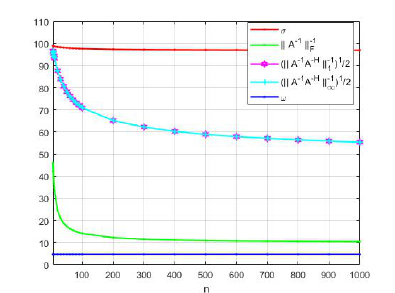
Figure 1: a 1 , a 2 = 7/3, 5/3 [i=2]. Figure 2: a 1 , a 2 , a 3 = 10/3, 1/3, 8/3